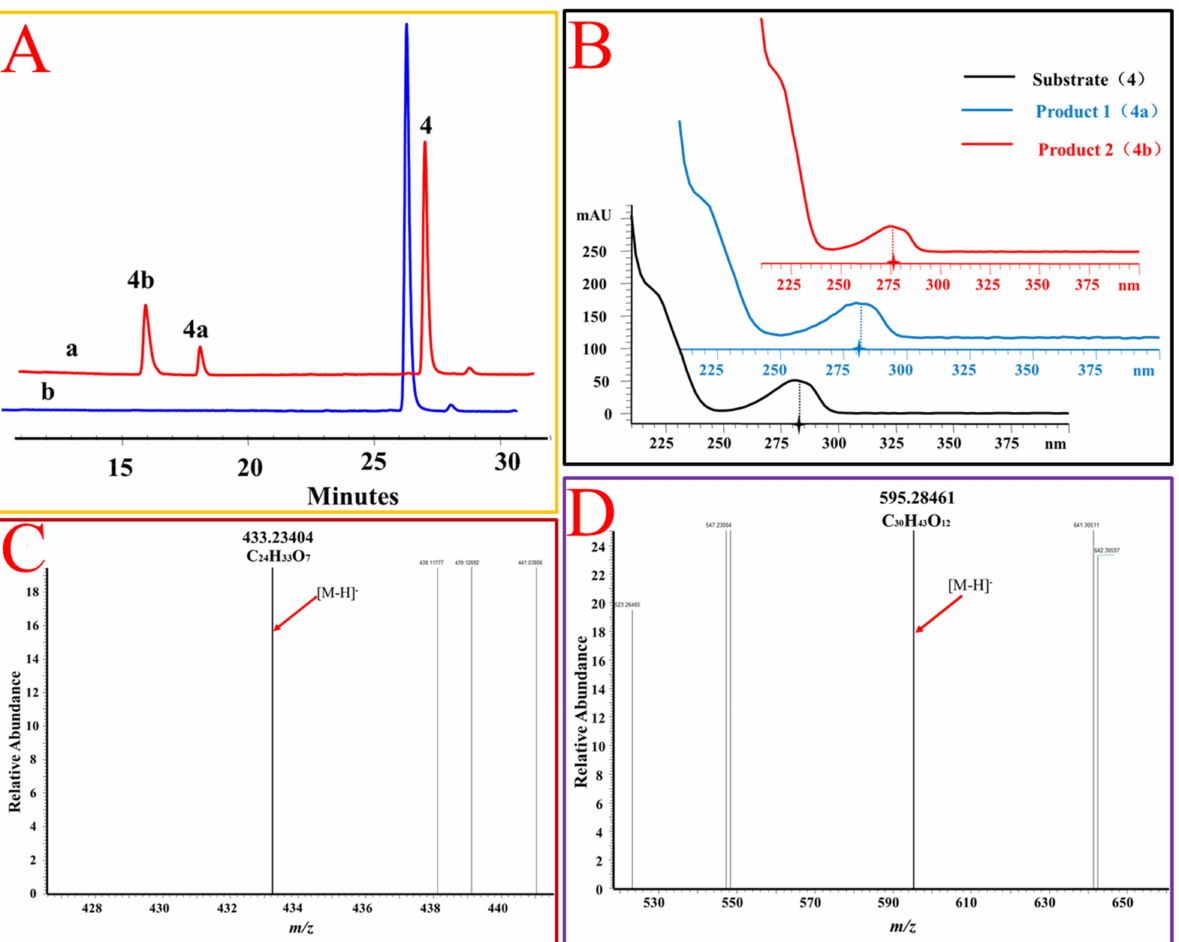
Figure 5. OcUGT1-catalyzed glucosylation of estradiol ( 4 ). ( A ) HPLC profiles of estradiol ( 4 ) glucosylation. ( a ) the reaction mixture of estradiol ( 4 ) with the purified OcUGT1; ( b ) the reaction mixture of estradiol ( 4 ) without the purified OcUGT1. 4 , 4a, and 4b refer to estradiol ( 4 ) and its mono-glucoside and bioside, respectively. ( B ) UV spectra of estradiol ( 4 ) and its glucosides. ( C ) HR-ESI-MS spectrum of estradiol mono-glucoside ( 4a ). ( D ) HR-ESI MS spectrum of estradiol bioside ( 4b